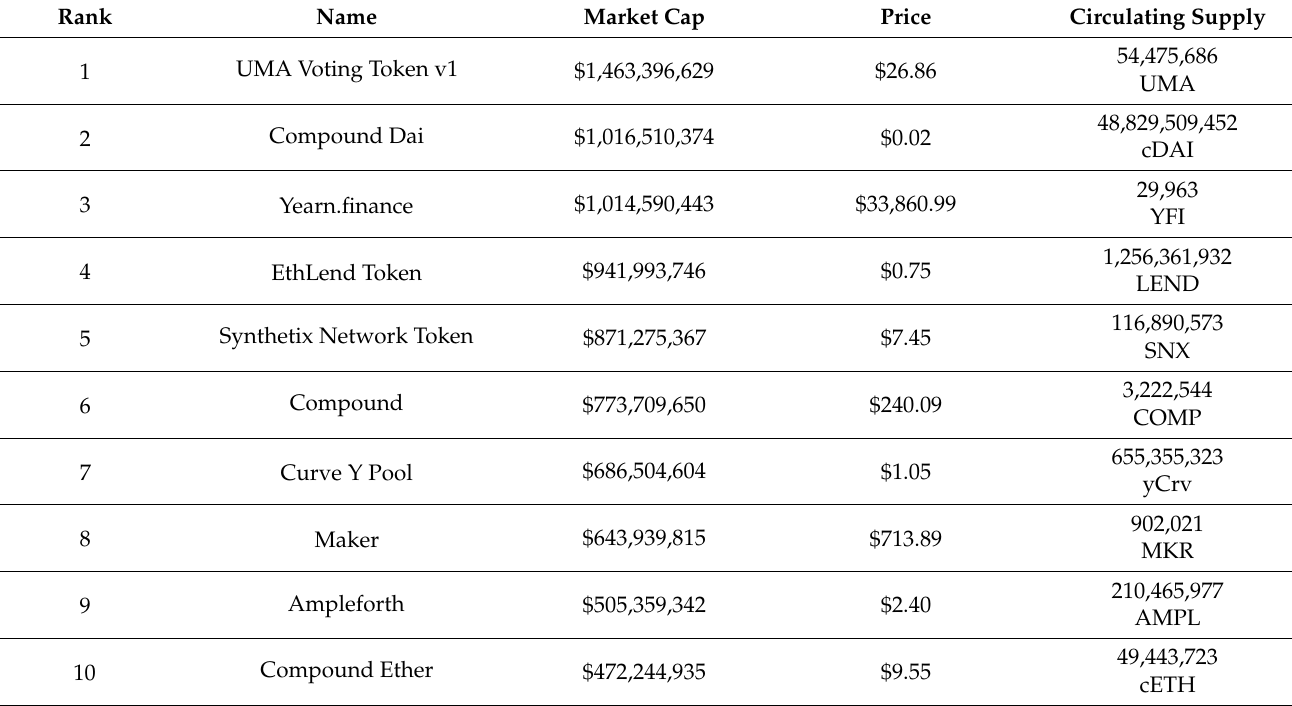
Table 2. The top 10 on market capitals of decentralized trading systems in